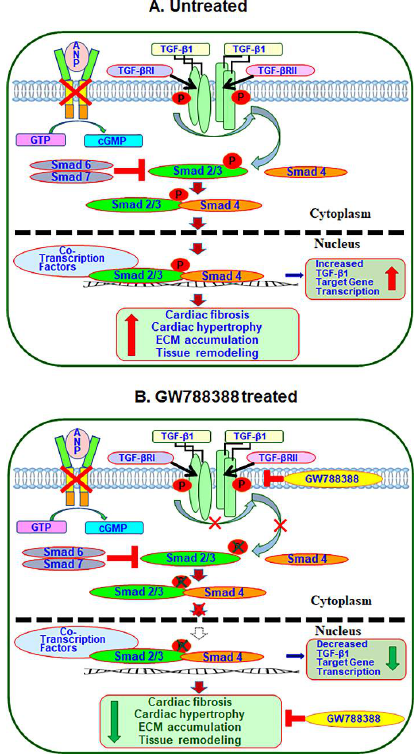
Figure 10. Schematic diagram representation of the proposed mechanisms whereby treatment with the TGF- β 1R antagonist GW788388 inhibits the development of cardiac fibrosis and remodeling in Npr1 gene-ablated mutant mice: disruption of Npr1 gene leads to an unbalanced activation of TGF- β 1 signaling cascade that triggers the expression of fibrotic markers, thereby activating the specific molecular and structural changes leading to fibrosis and hypertrophic remodeling in a mutant mouse heart. Treatment with the TGF- β 1 receptor antagonist GW788388 ameliorates by blocking the activation and nuclear translocation of SMAD-mediated signaling networks, which protects against fibrosis and hypertrophic remodeling in 0-copy and 1-copy mutant mice